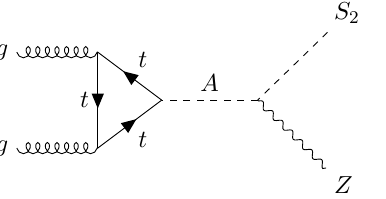
Figure 6 . 2 (cid:27) observed exclusion limits from t (cid:22) t resonance searches by CMS [53] in the M tan (cid:12) -plane for the 2HDM+S (top) and 2HDM+PS (bottom). The parameters are (cid:12)xed to the values from eq. (4.4) and M = 400 GeV. The limits derived from searches for a scalar (pseudoscalar) a=S 2 resonance H=S 1 ( A ) are given in orange (red).